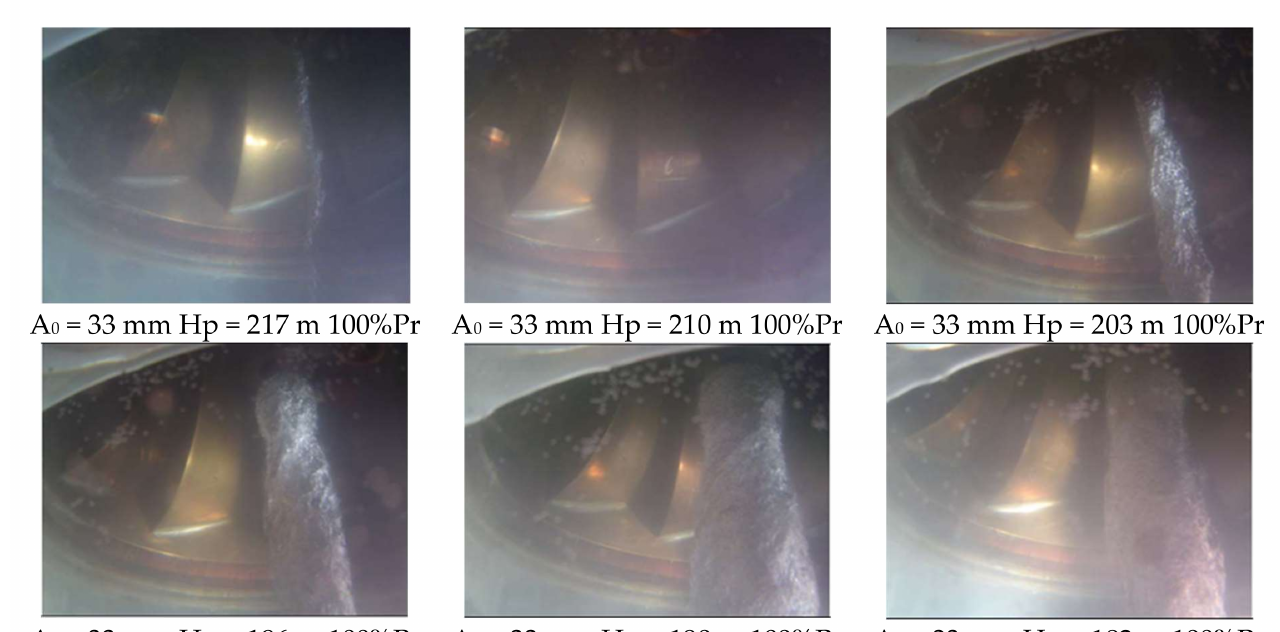
Figure 9. Experimental value of pressure pulsation of draft tube (a 0 = 33